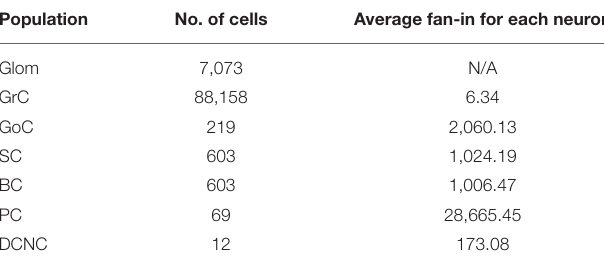
deep cerebellar nucleus cell (DCNC) layer is the output. The TABLE 1 | Number of cells and their average individual fan-ins (incoming